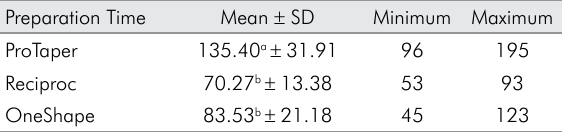
Table 2. Preparation Time with the Different Instruments